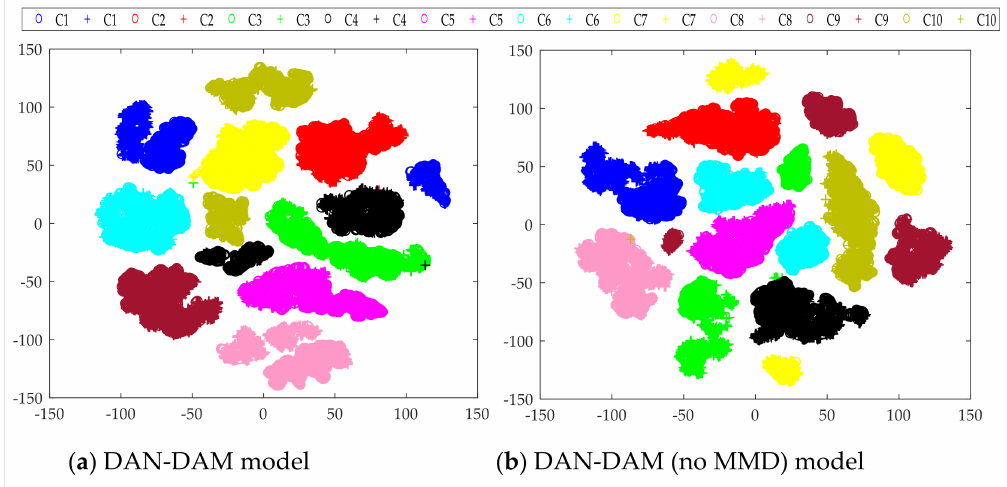
Figure 6. Feature visualization via t-SNE in output layers for open datasets.